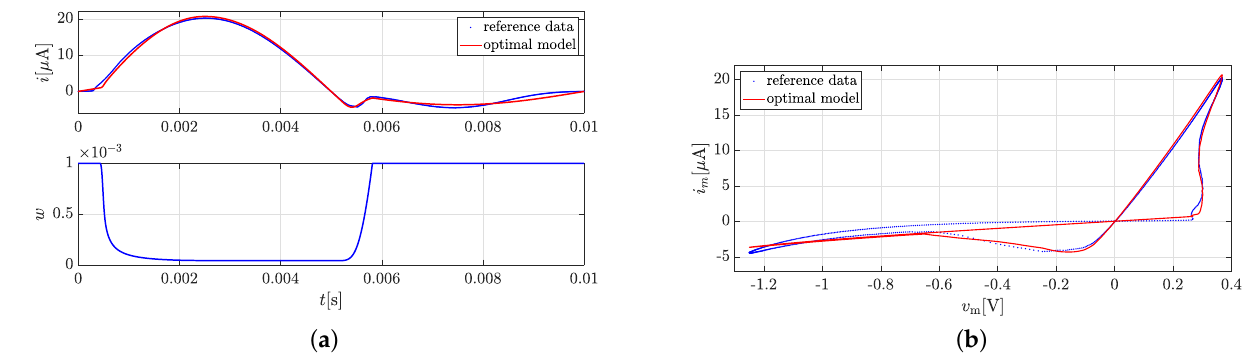
( a ) ( b ) Figure 9. Optimization results obtained for the VTEAM model for memristor with carbon dopant and sine wave excitation voltage with f = 100Hz and V s = 1.5V. F ( x , y ) = 3.3647 × 10 − 3 . ( a ) Comparison graph of the memristor current obtained from the model and the reference data, and the internal variable w ( t ) ; ( b ) Corresponding i m − v m plot.